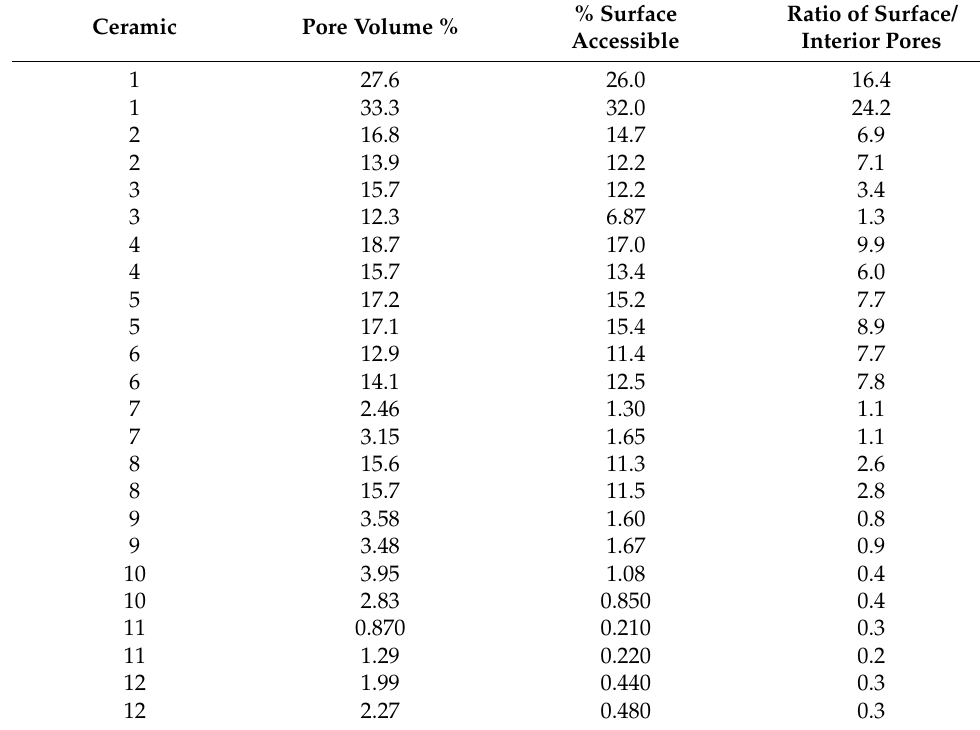
Table 3. Volume percent pores, percent surface accessible, and the ratio of pores accessible to a surface versus interior-only